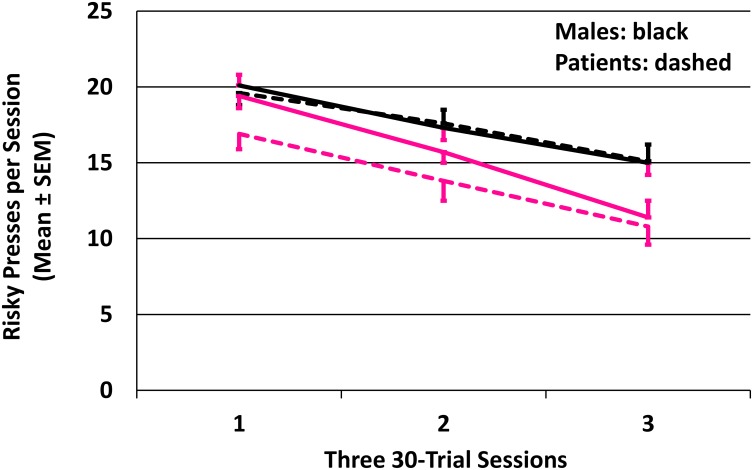
Decline in risky presses as probability of loss increased.Four groups: patient males, comparison males, patient females, comparison females. Raw (not fitted) data shown. Comparison males' error bars: red to reduce confusing overlaps. Trials required a choice: a cautious response earned 1 cent; a risky response either won 5 or lost 10 cents. Probability of winning after risky choices declined from 0.78 to 0.22 as game progressed.